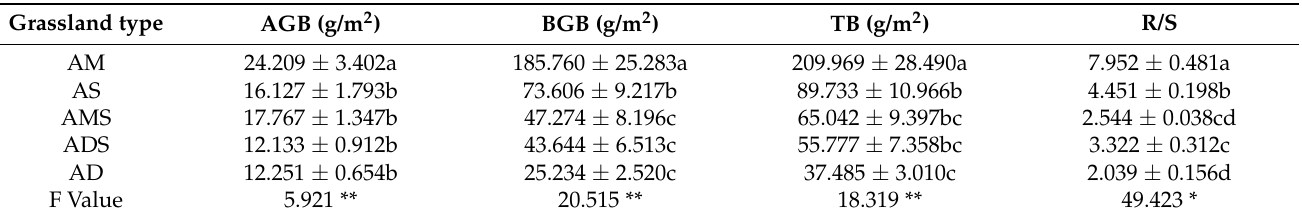
Table 2. Differences of aboveground biomass (AGB), belowground biomass (BGB), total biomass (TB) and BGB to AGB ratio (R/S) ratio in 5 alpine grassland